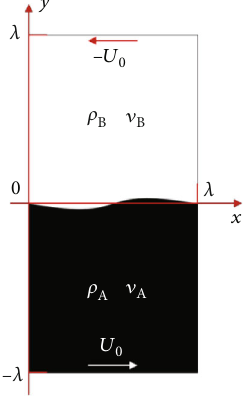
Figure 2: Schematic diagram for Kelvin-Helmholtz